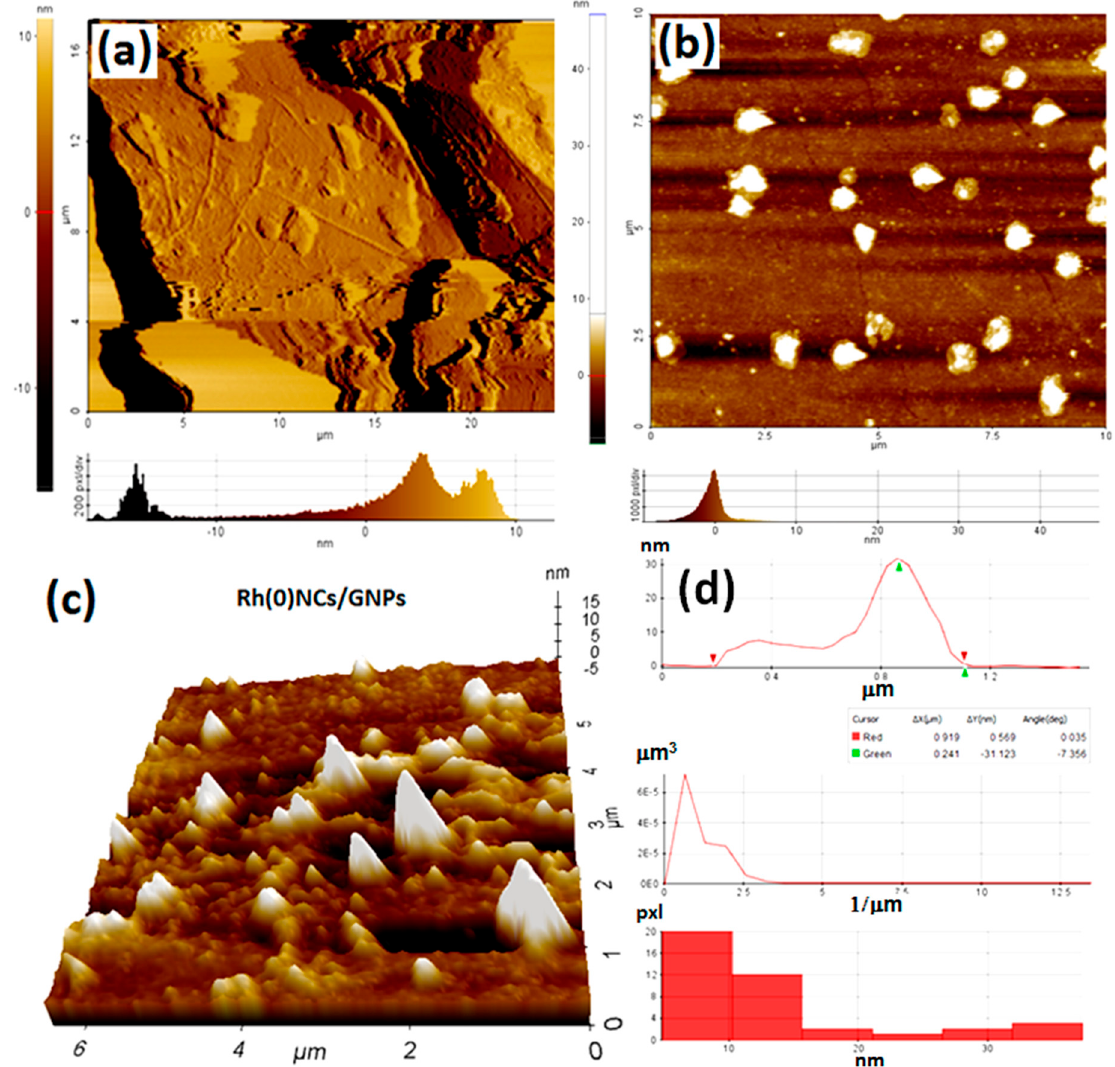
Figure 2. Atomic force microscope (AFM)one-dimensional (1D) and three-dimensional (3D) profile of ( a ) graphene platelets (GNPs) and ( b , c ) Rh(0)NCs/GNPs and ( d ) the particle size distribution of Rh nanoparticles in Rh(0)NCs/GNPs.